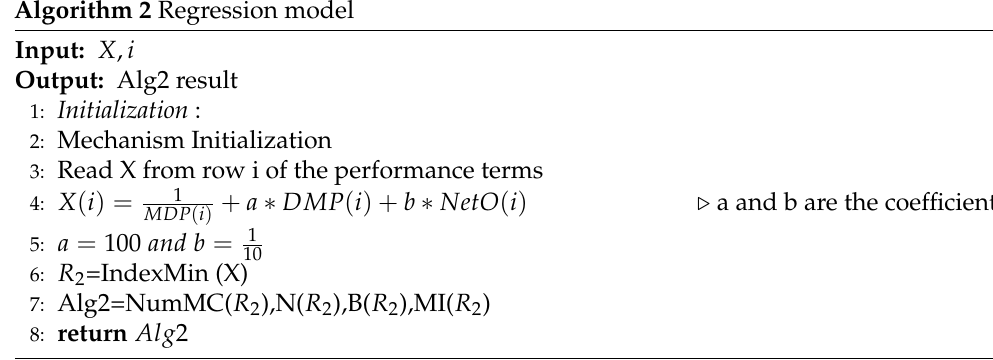
Algorithm 2 Regression